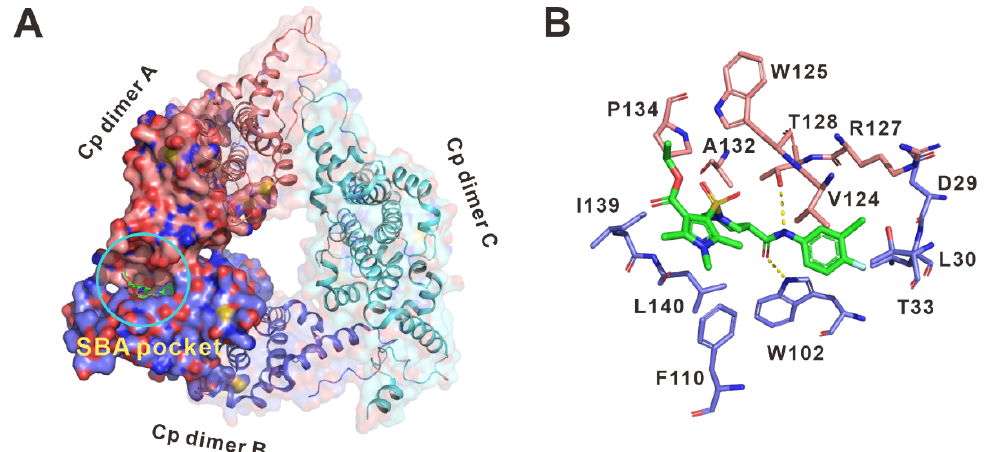
Figure 8. Putative binding mode of C-39 with HBV core protein. ( A ) Surface view of the putative binding model of C-39 in the SBA pocket. ( B ) Detailed molecular interactions of the HBV core proteins with C-39.